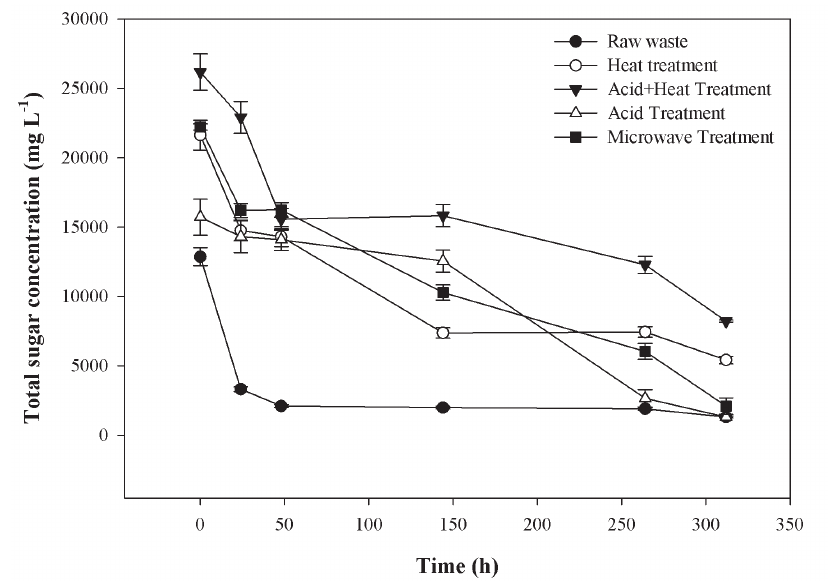
Fig. 3 – Total sugar consumption during yeast fermentation Table 1 – Process parameters for yeast fermentation